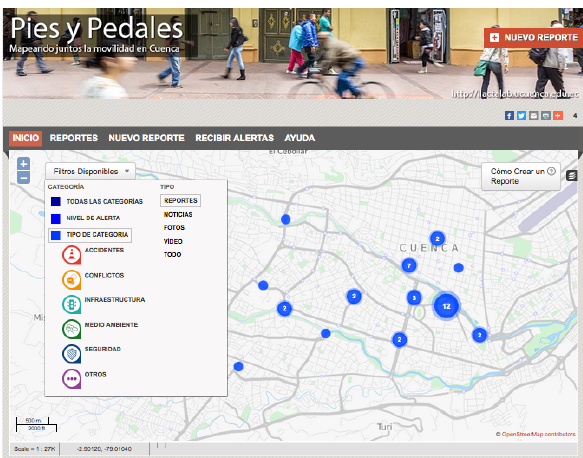
Figure 1: Platform for collaborative mapping of mobility. Source: